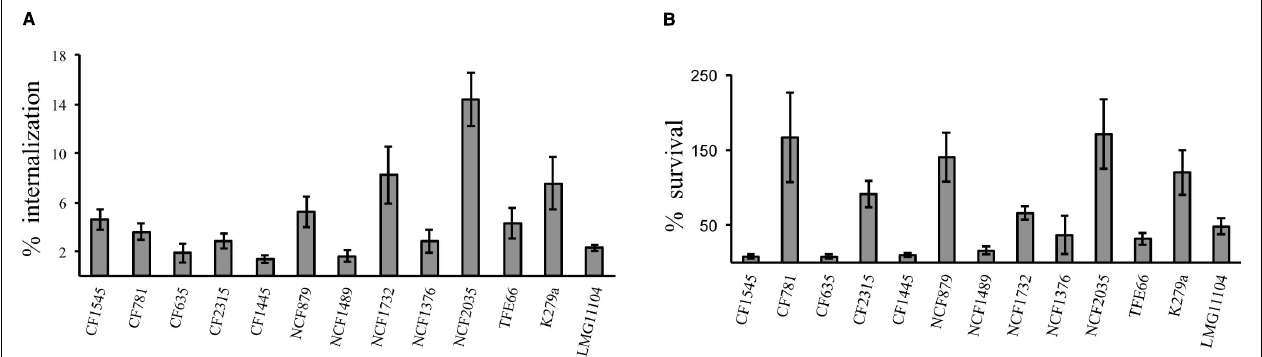
FIGURE 2 | DC infection assays. (A) Entry Index (EI). Bar graphs shown the percentage internalization of S. maltophilia strains after 1 h of infection with DCs. (B) Intracellular Replication Index (RI). Bar graphs shown the percentage survival